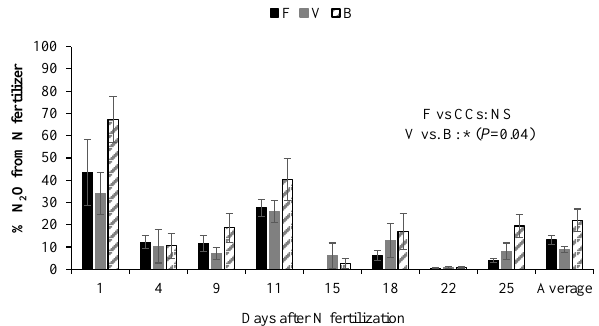
fig04 Figure 4. Proportion of N 2 O losses (%) that come from N syn- thetic fertilizer during Period II, for the three CC treatments (fallow, F; vetch, V; and barley, B). Vertical lines indicate standard errors. “NS” and ∗ denote not significant and significant at P <0.05, re-